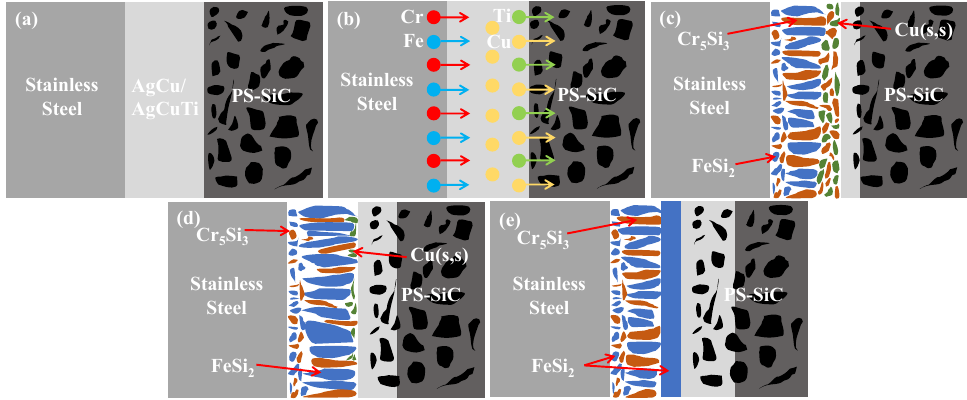
Figure 9. Schematic of the PS-SiC-stainless steel brazed joint formation mechanism.